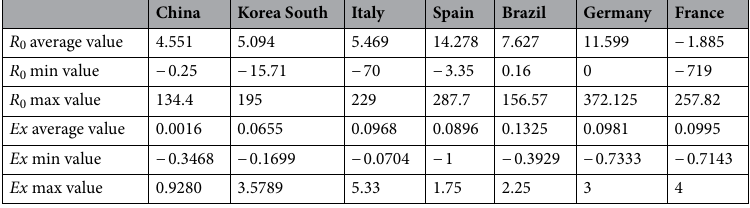
Table 5. The measurement of the reproduction number and the exponential growth rate according to the formula derivation method.